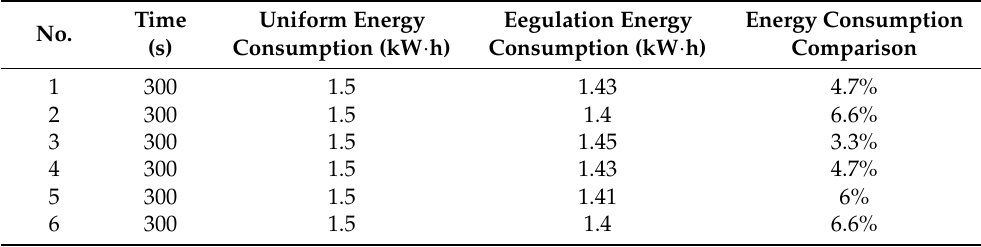
Table 7. Comparison of energy